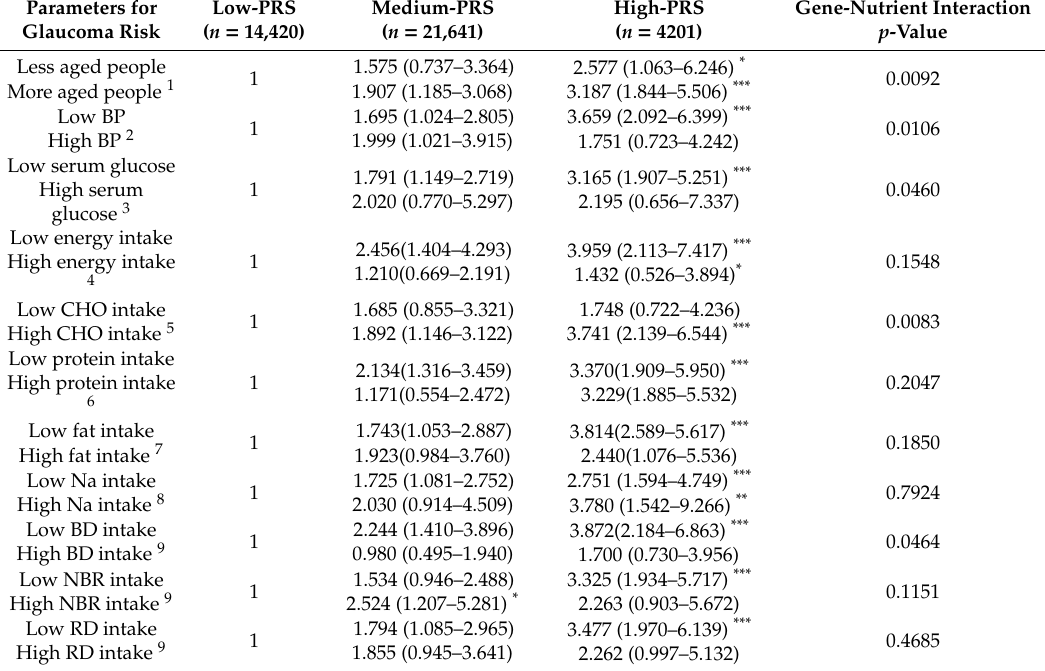
Table 5. Adjusted odds ratios for the glaucoma risk by polygenetic risk scores (PRS) of the best model and gene-environmental interactions after covariate